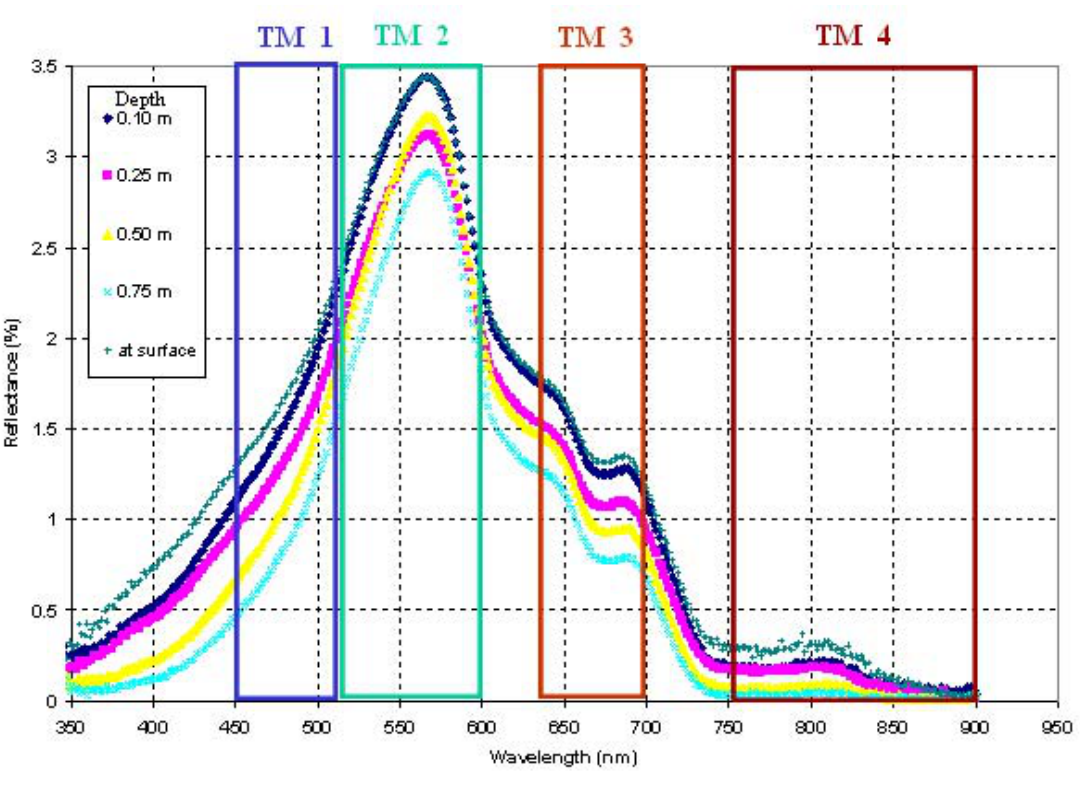
Figure 3. Positioning of the GER1500 reflectance values to match the Landsat-5 TM bands 1, 2, 3 and 4. The reflectance spectra correspond to Queen Mary reservoir, acquired at different water depths on 23 September 1998.